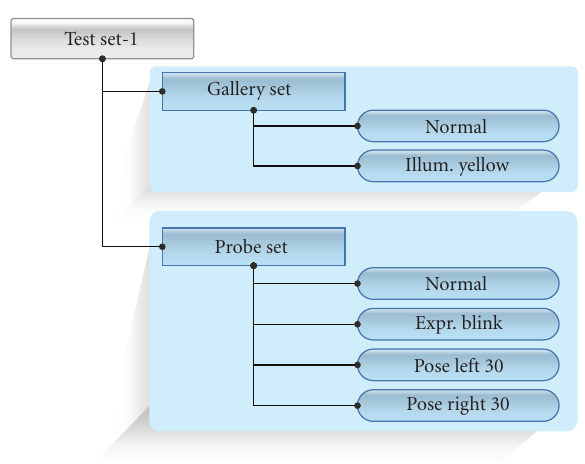
Figure 2: Example of setting the facial image test